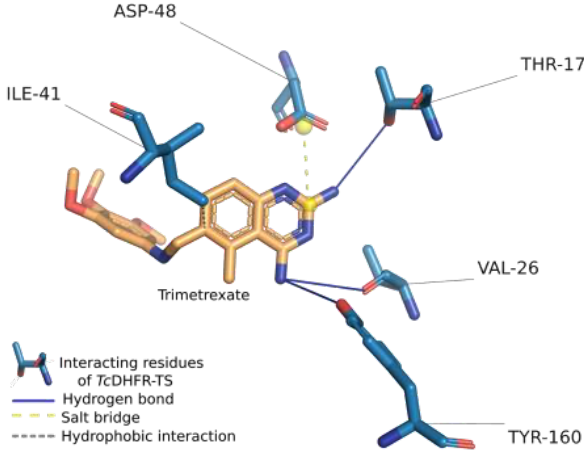
Figure 1. Trimetrexate interactions in complex with Trypanosoma cruzi dihydrofolate reductase- thymidylate synthase ( Tc DHFR-TS). The crystal structure of the complex was analyzed using the protein-ligand interaction profiler (PLIP).